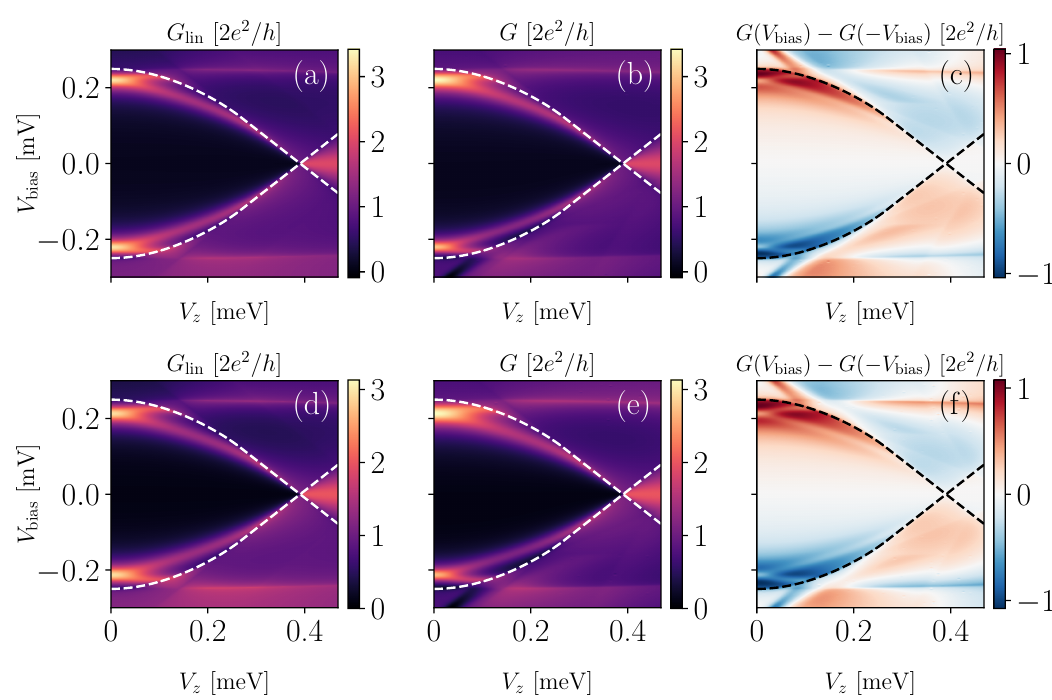
Figure 4: Two-terminal conductance as a function of Zeeman field and bias voltage in a proximitized nanowire with ∆ = 0.25 meV. The system in the top panels has a square barrier and in bottom panels a triangular barrier. The linear response conduc- tance ((a) and (d)) is particle-hole symmetric below the induced gap (dashed lines). In contrast, the finite-bias conductance ((b) and (e)) shows significant particle-hole asymmetry below the gap which we plot explicitly in (c) and